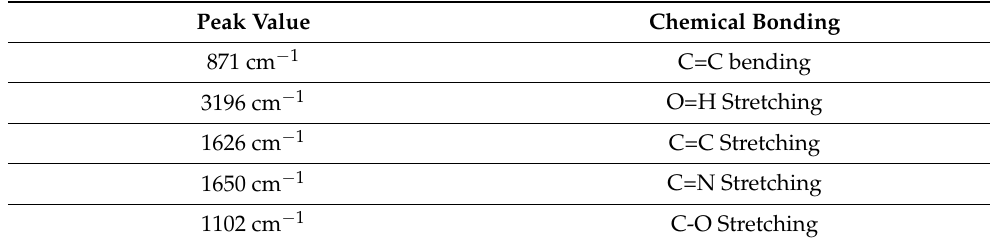
Table 2. FTIR Peak